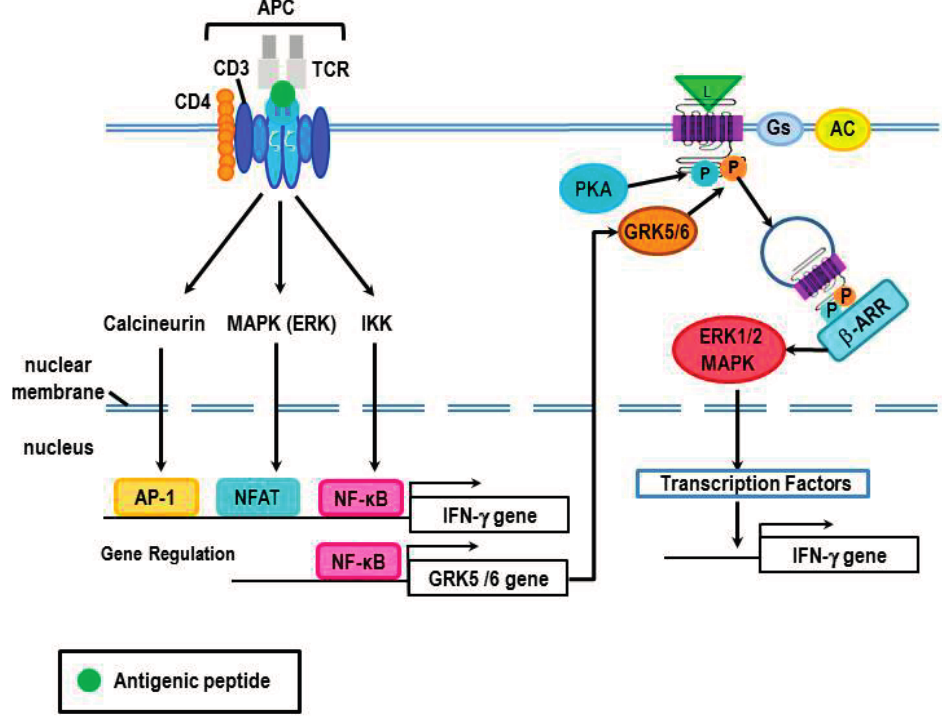
Figure 10. A proposed mechanism for β 2 -AR-mediated increases in IFN- γ in Th0